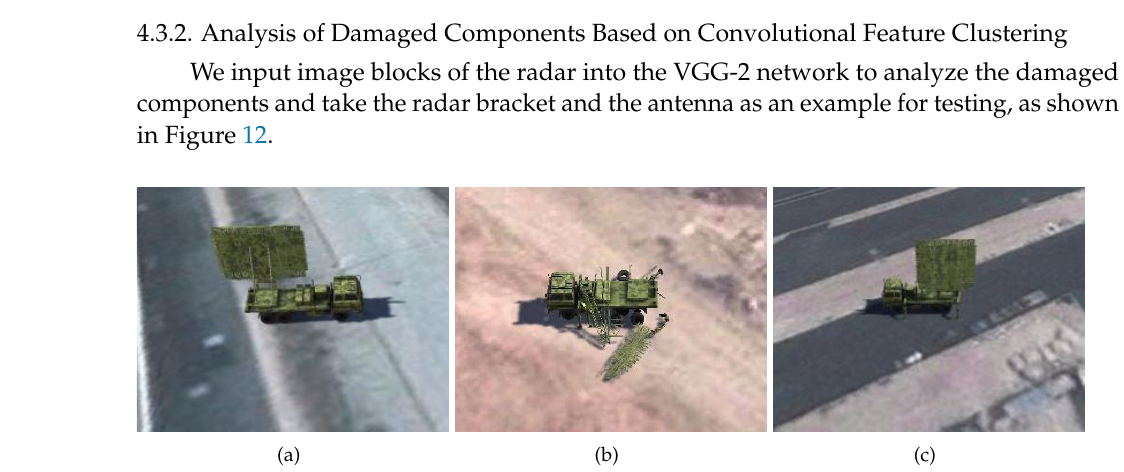
Figure 11. Frequency distribution of the target’s different components. ( a ) Radar antenna. ( b ) Radar bracket.